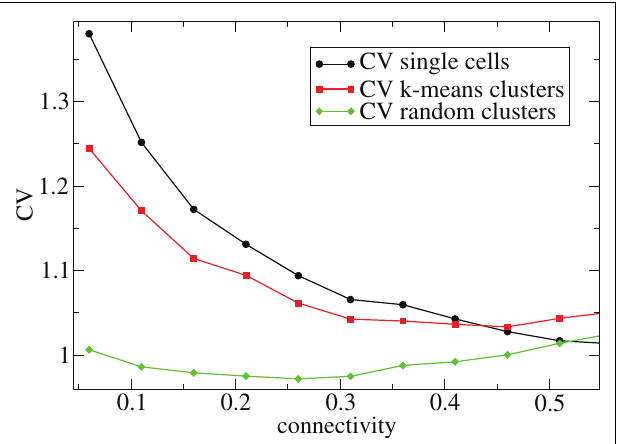
FIGURE 7 | 500 cell network simulations under variation of connectivity for weak input, r C = 0.0085, b C = 0.001, α = 5, but faster inhibitory neurotransmitter decay time τ g = 20. Each point is calculated from a 50-s time series from a different network simulation. Black solid circles – mean CV over all cells. Red solid squares – mean CV of k-means generated clusters. Green solid diamonds – mean CV of randomly generated